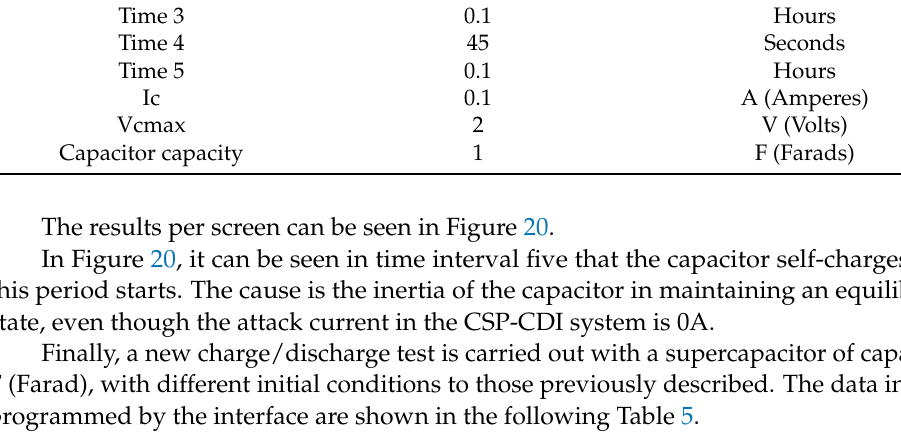
Figure 19. Detailed graphs for the loading and unloading test at Vcmax = 1.8 V and Icon = 0.1 A.